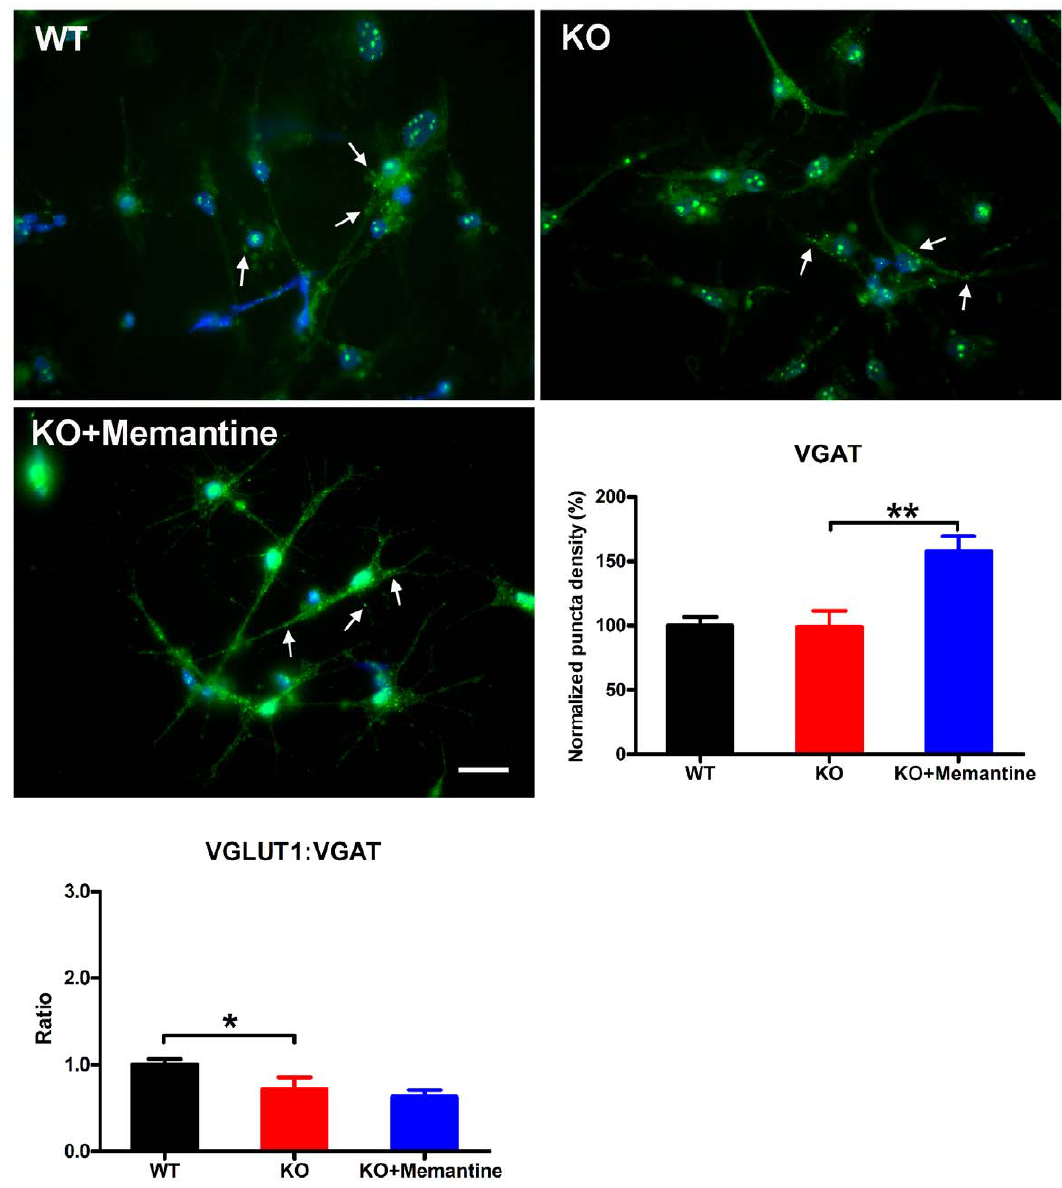
Figure 7. Memantine stimulated the formation of inhibitory synapses in Fmr1 -KO CGCs. Representative photomicrographs of labeling of VGAT (arrow) in WT CGCs, KO CGCs and KO CGCs treated with memantine. Green, VGAT; Blue, Hoechst, scale bars, 25 m m. The histogram shows quantification of puncta size using image analysis and ratio of excitatory synapses to inhibitory synapse. WT, n=23; Fmr1 -KO, n=25; Fmr1 - KO + Memantine, n=25. * p , 0.05, ** p , 0.01.